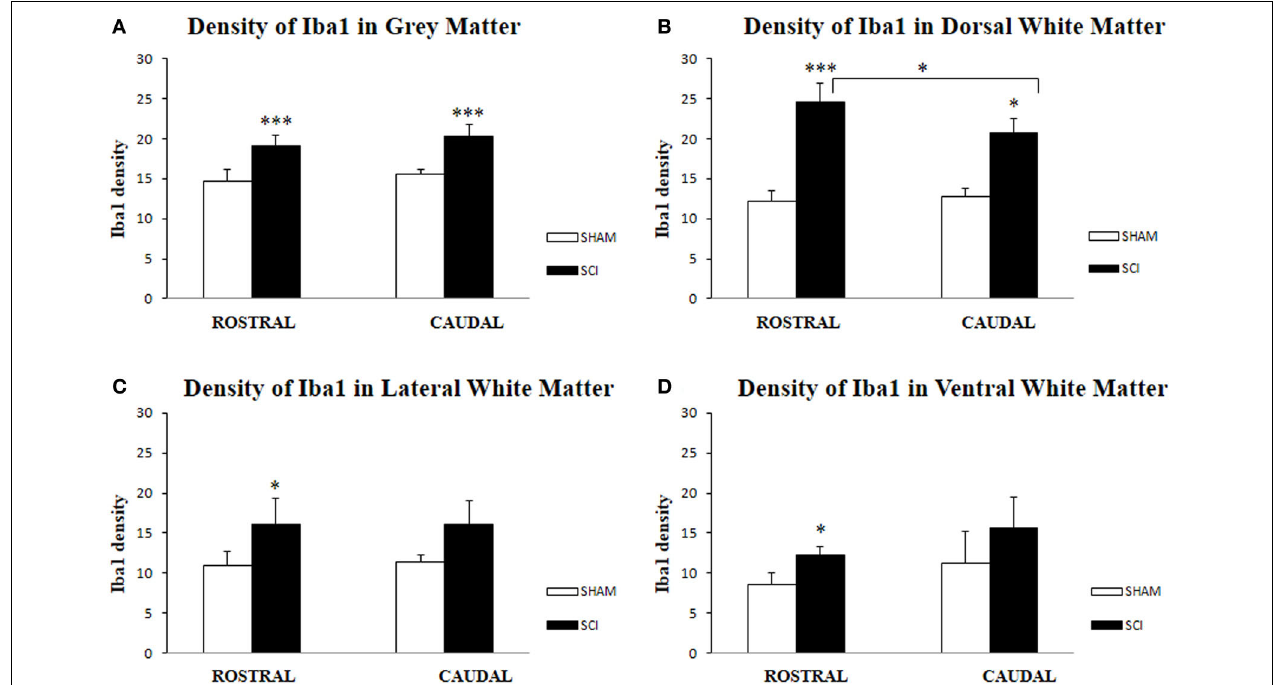
FIGURE 6 | Density of Iba1-IR microglia ( n = 4) in the spinal cord of sham and rats after SCI in gray (A), White Matter (B,C,D); Dorsal White Matter (B), Lateral White Matter (C) and Ventral White Matter (D). Density of Iba1-IR positive microglia was